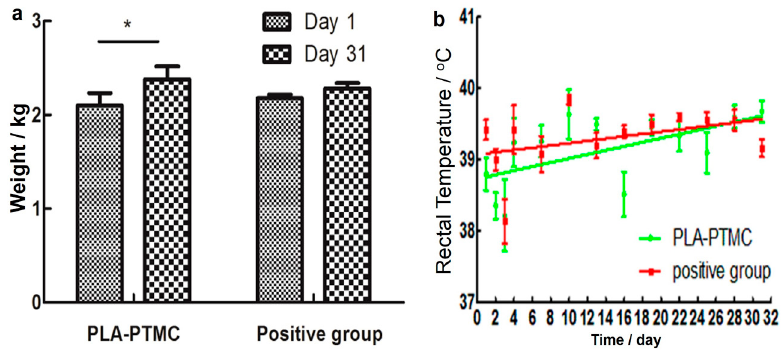
Figure 7. Weight and temperature changes of the rabbits during the experiments. ( a ) Presents the change of weight during the experiment; ( b ) shows the rectal temperature of the rabbits. “*” present there exists statistic difference.